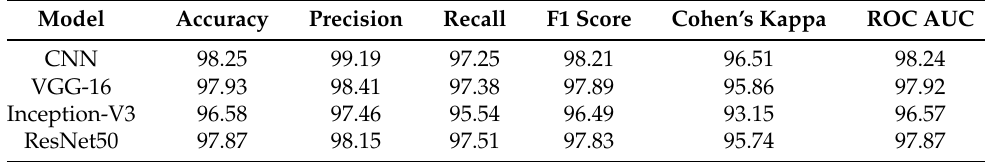
Table 4. Results of fine-tuned pre-trained models.